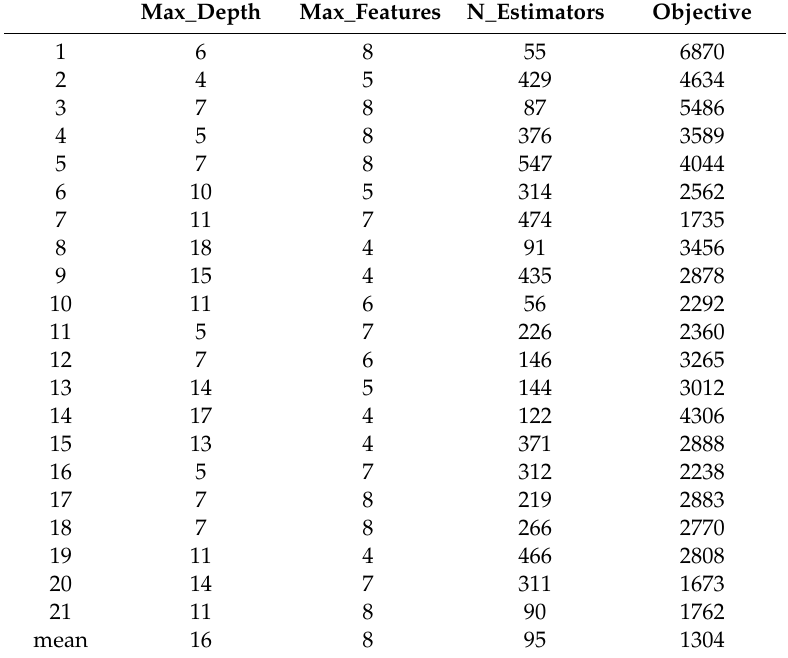
Table A2. Optimal results of Bayesian hyper-parameter optimization for RF in this region.